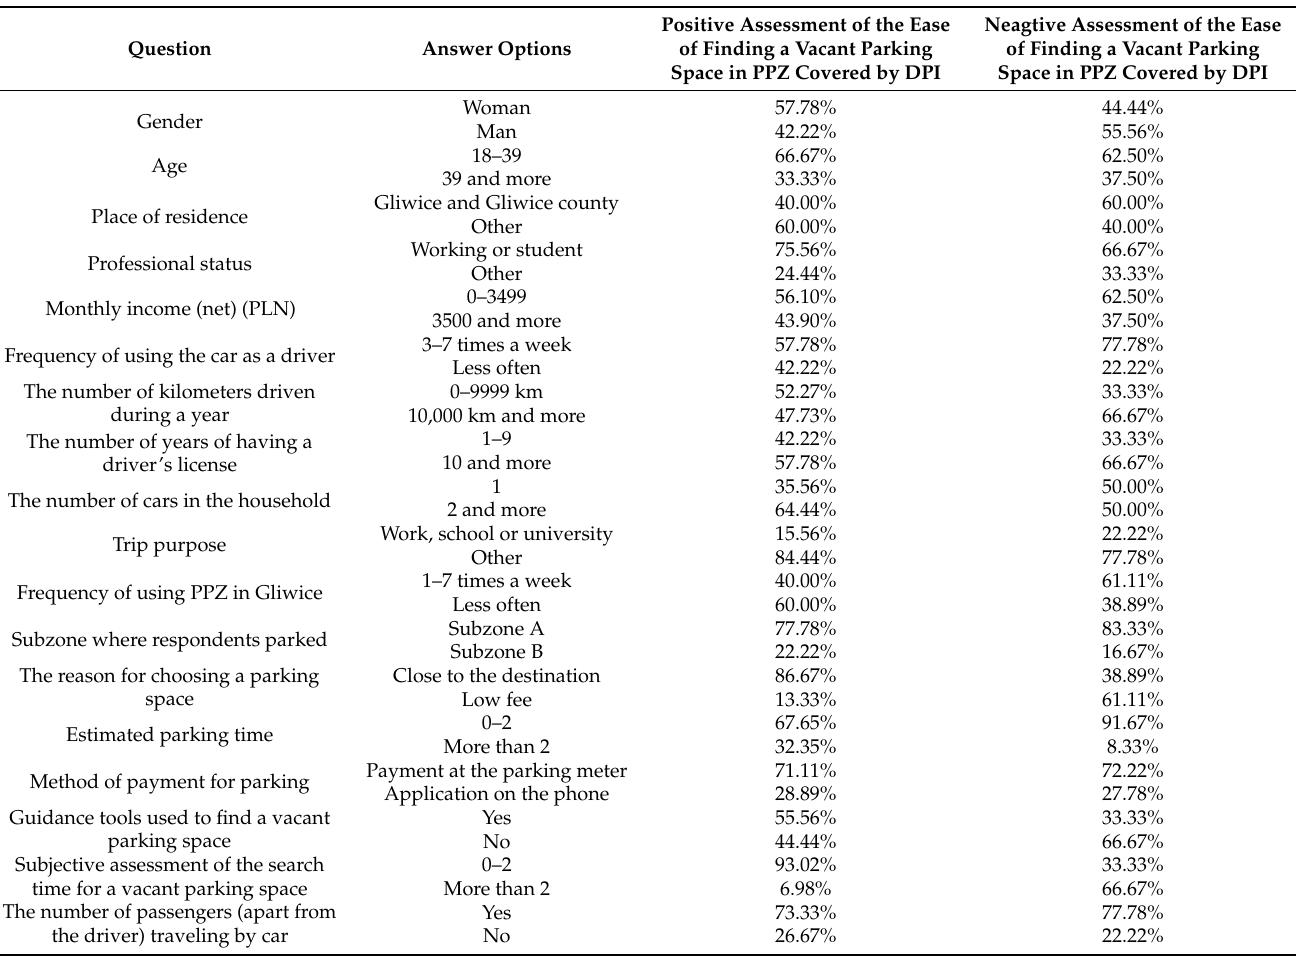
Table 2. Characteristics of the respondents in terms of the ease of finding a vacant parking space in PPZ covered by